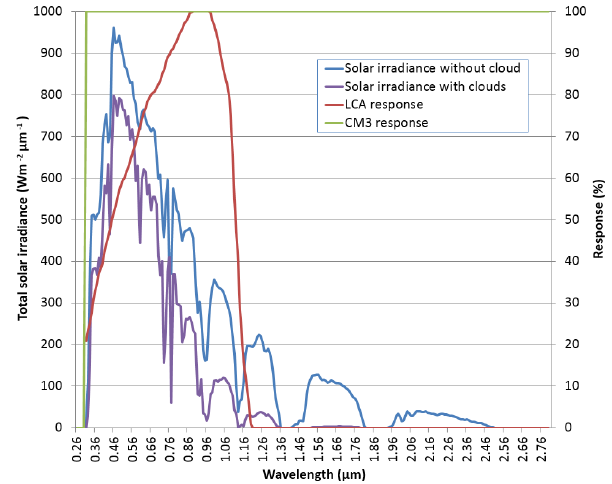
Figure 2. HOBO ® Pendant Temperature/Light Data Logger and CM3 responses as a function of the wavelength and two examples of total solar irradiances for a clear sky (in blue) and for a cloudy sky (in purple) given by the DISORT model (Stamnes et al., 1988; Wm − 2 µm − 1 )